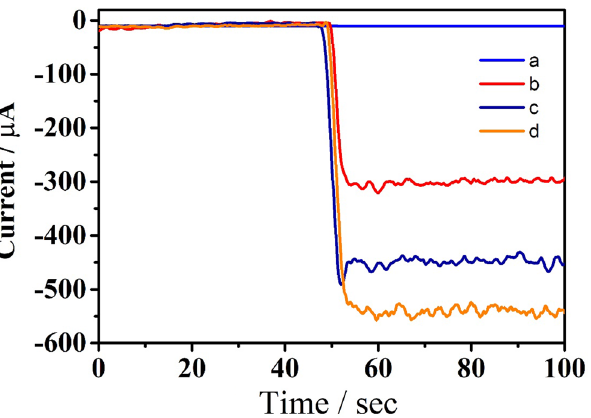
Figure 1. The i-t responses of different materials (i-t curve was recorded at − 0.4 V in pH 7.4 of PBS): ( a ) bare GCE; ( b ) Cu@L-Asp/Pt NPs; ( c ) Cu@L-Asp/Pd NPs; ( d ) Cu@L-Asp/Pt–Pd